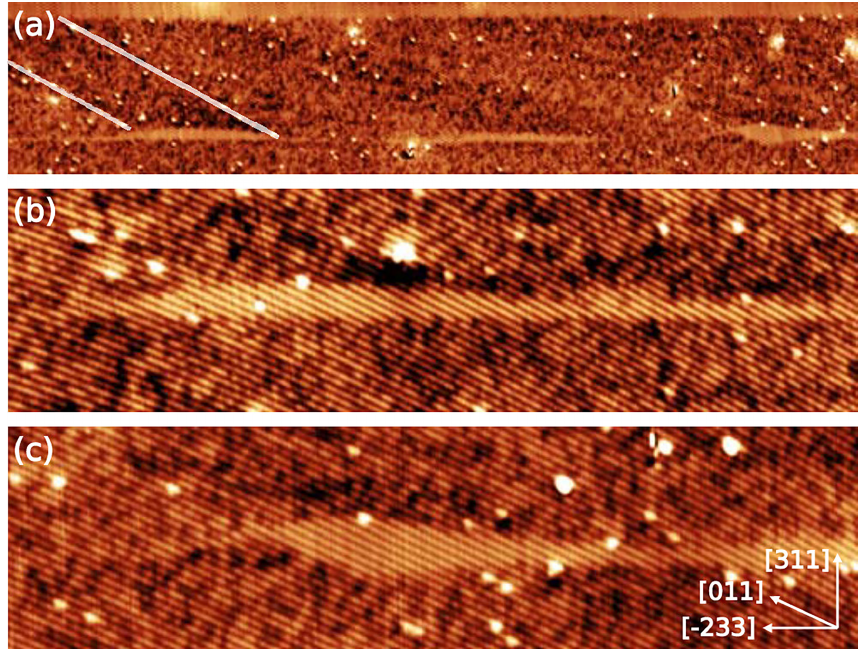
Figure 15. ( a ) 170 × 35 nm 2 topographic X-STM image of the QD layer. An AlAs-rich region ema- nating from the top of one of the QDs is marked by two transparent lines; 65 × 16 nm 2 topogrpahic image of a typical QD with a smooth ( b ) and rough ( c ) bottom AlGaAs/GaAs interface. Reprinted from Ref. [75], © 2011 with the permission of AIP